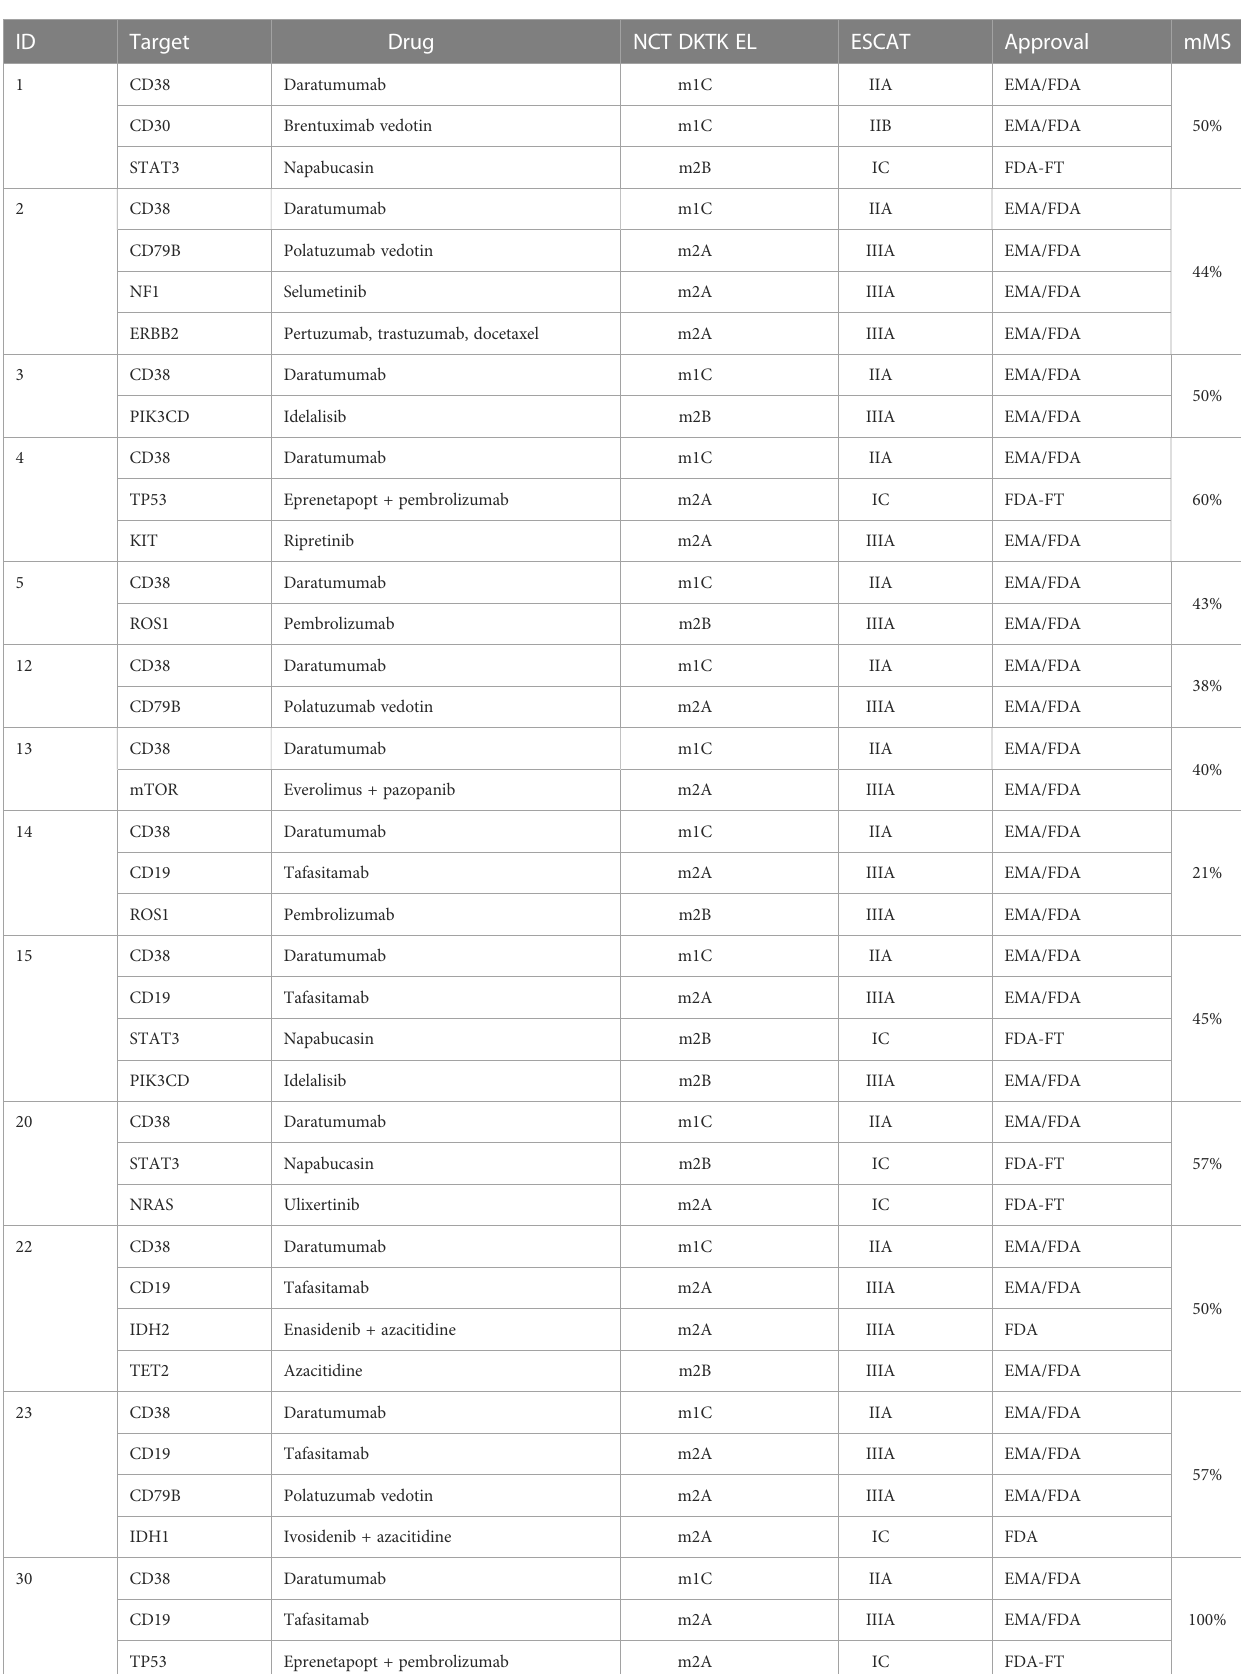
TABLE 2 Summary of MTB treatment